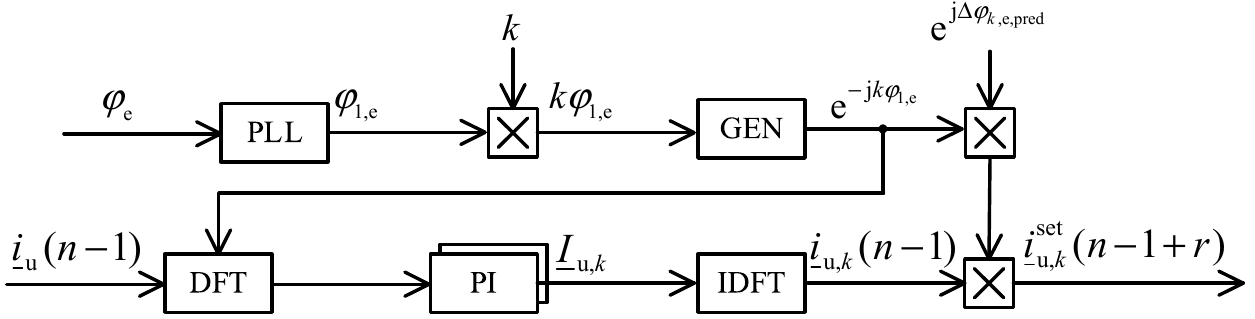
Figure 3. Block diagram of the determination of the particular current harmonic to be compensated.